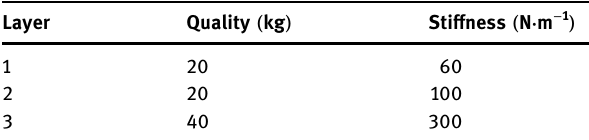
Table 1: Sti ff ness and mass information of each fl